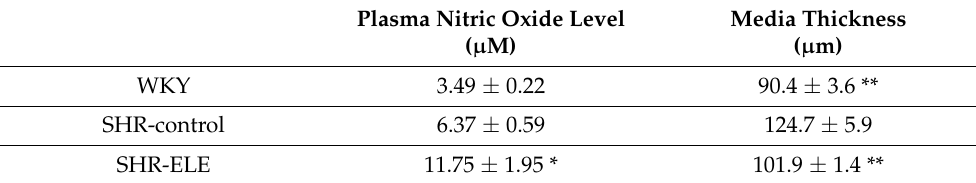
Table 2. Plasma NO levels and thoracis aorta ring media thickness in the indicated treatment